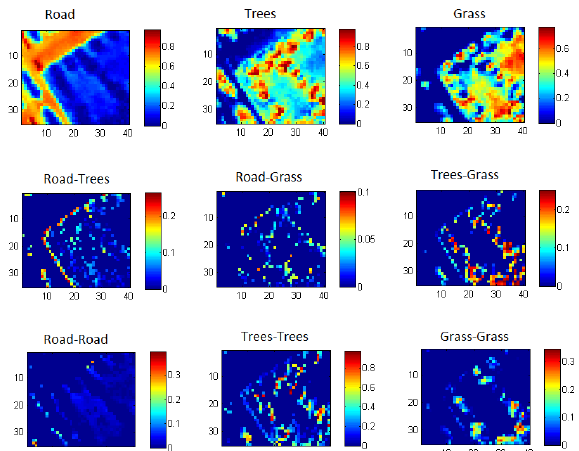
Figure 4. Fraction maps estimated using